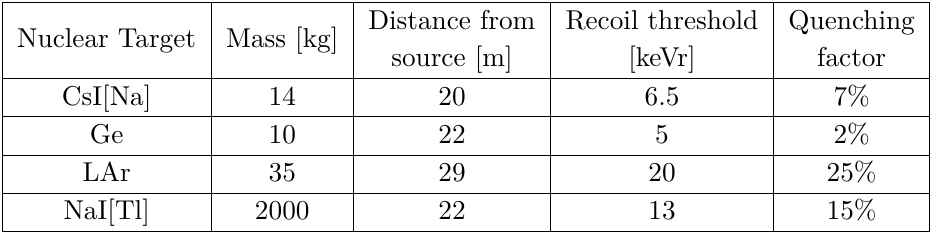
Table 2 . Parameters used in the calculation for the four detectors [3, 51]. There is a 10% uncertainty in neutrino flux aside from the uncertainties listed in the table.